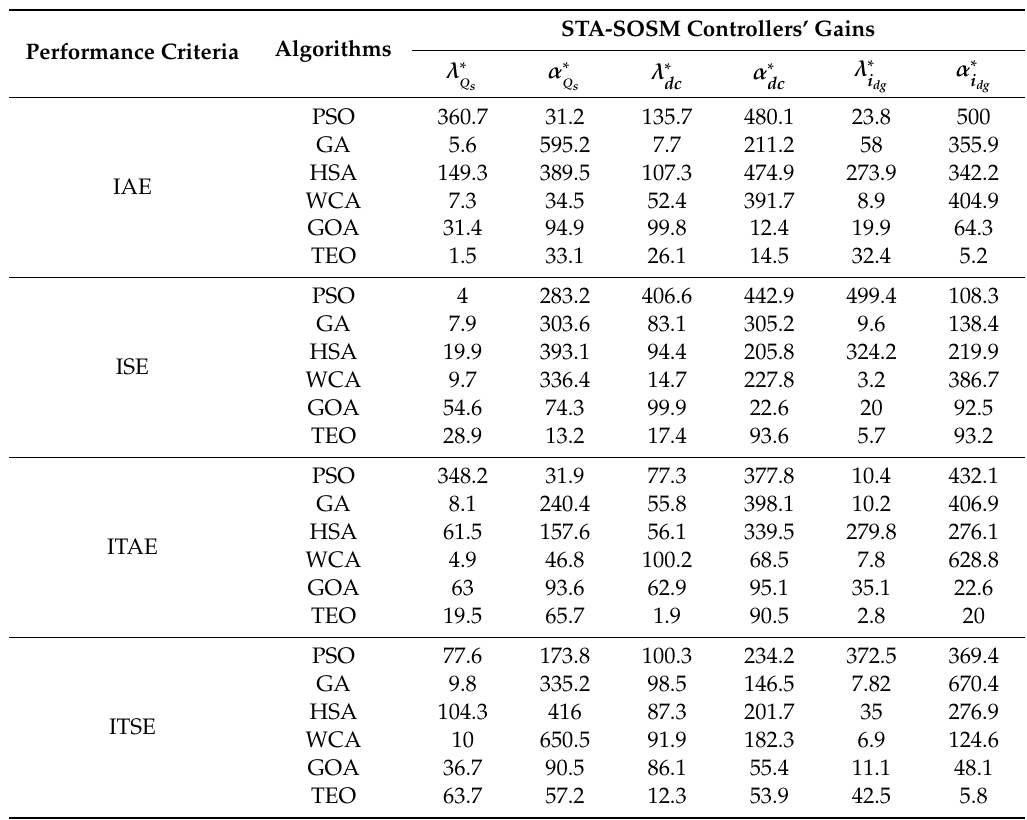
Table 2. Optimized decision variables of problem (35).